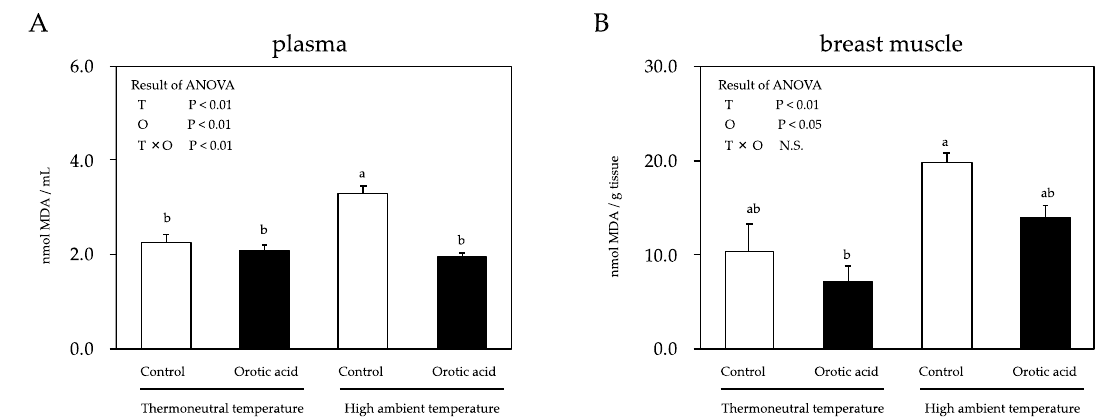
Figure 1. Effects of a cyclic high ambient temperature and feeding orotic acid on the plasma ( A ) and muscle ( B ) malondialdehyde (MDA) concentrations of broiler chickens. Results are expressed as mean ± standard error of the mean (SEM) ( n = 8). Means with the same superscript letter within columns are not significantly different at p < 0.05. T: the effect of high ambient temperature; O: the effect of feeding orotic acid; T × O: the statistical interaction between high ambient temperature and feeding orotic acid.